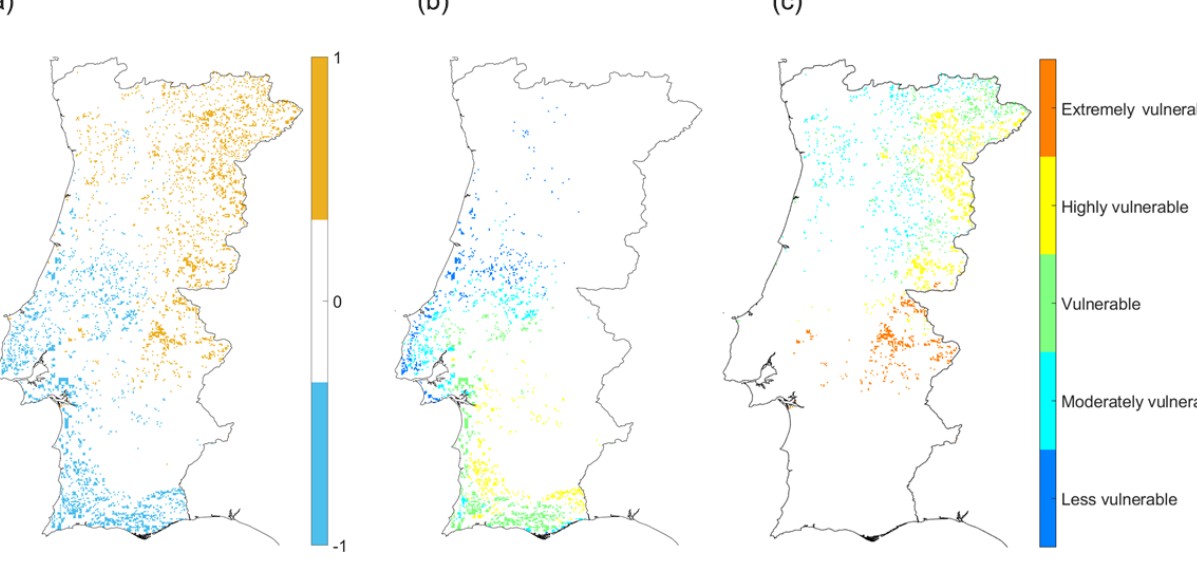
Figure 12. (a) Differences between the vulnerability maps obtained by the PCA and variance methods. Vulnerability classes map calculated from the PCA corresponding to the difference equal to (b) − 1 and (c)